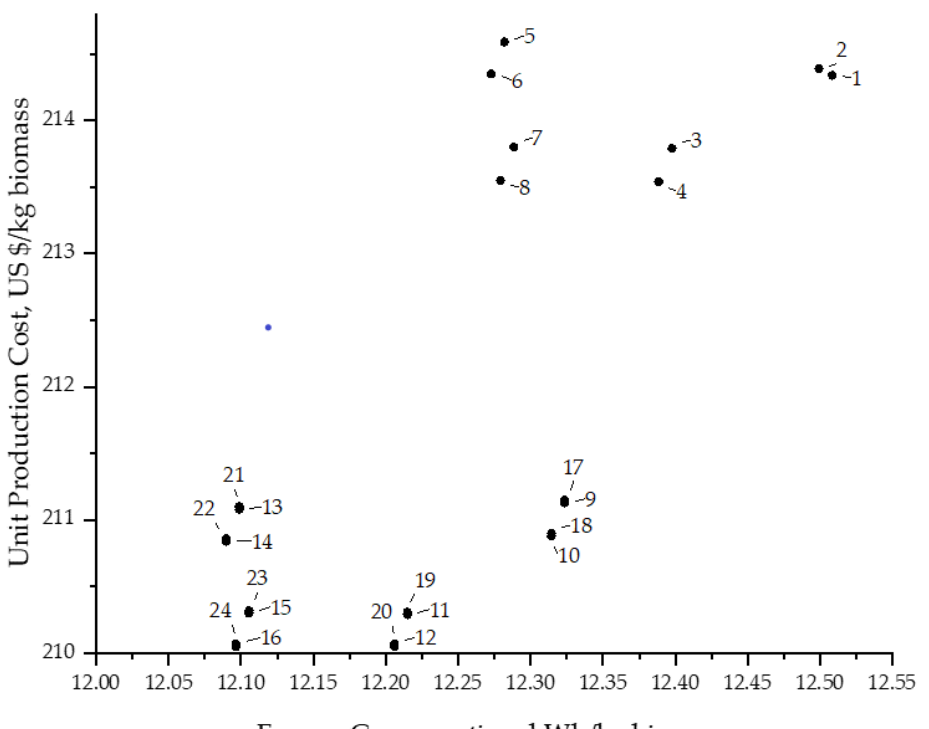
Figure 8. Total energy consumption vs. total production cost per kg biomass produced.